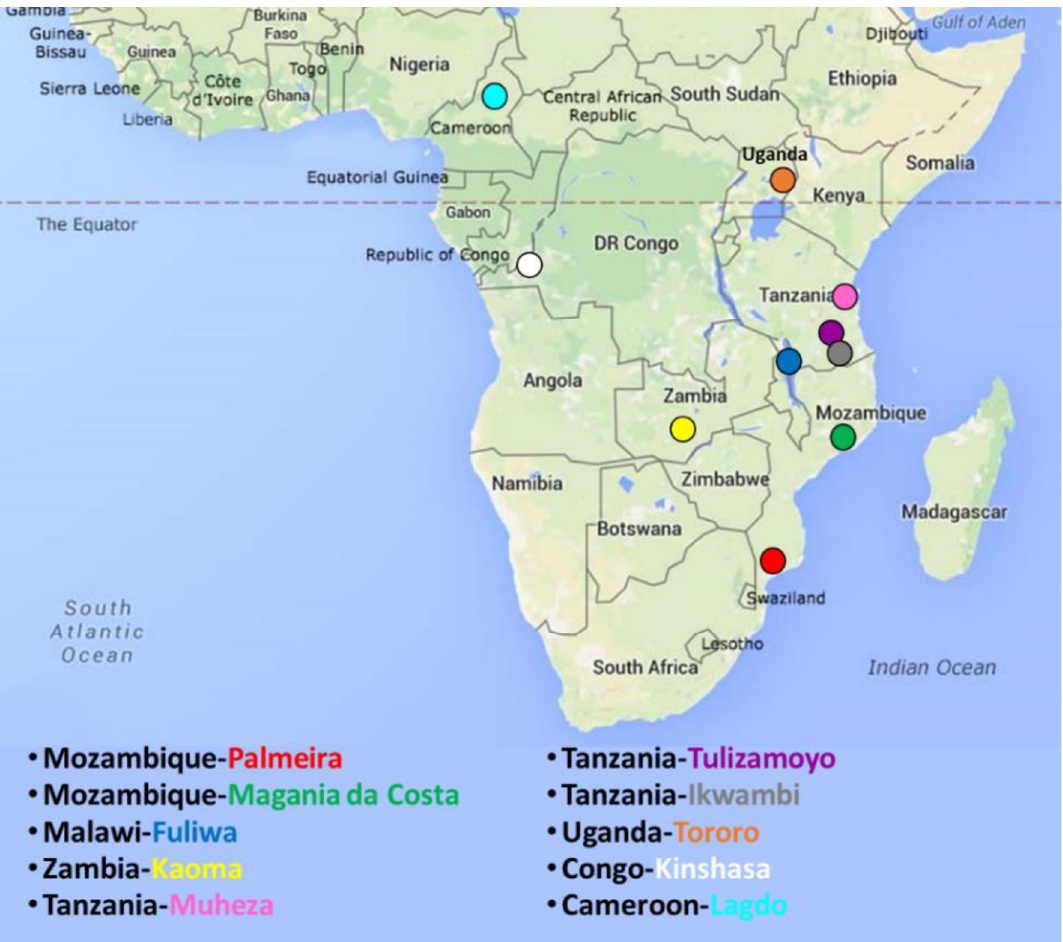
Figure 1. Map of Sub-Saharan Africa showing the sampling locations. Circle colour corresponds to sampling site colouring in the legend.